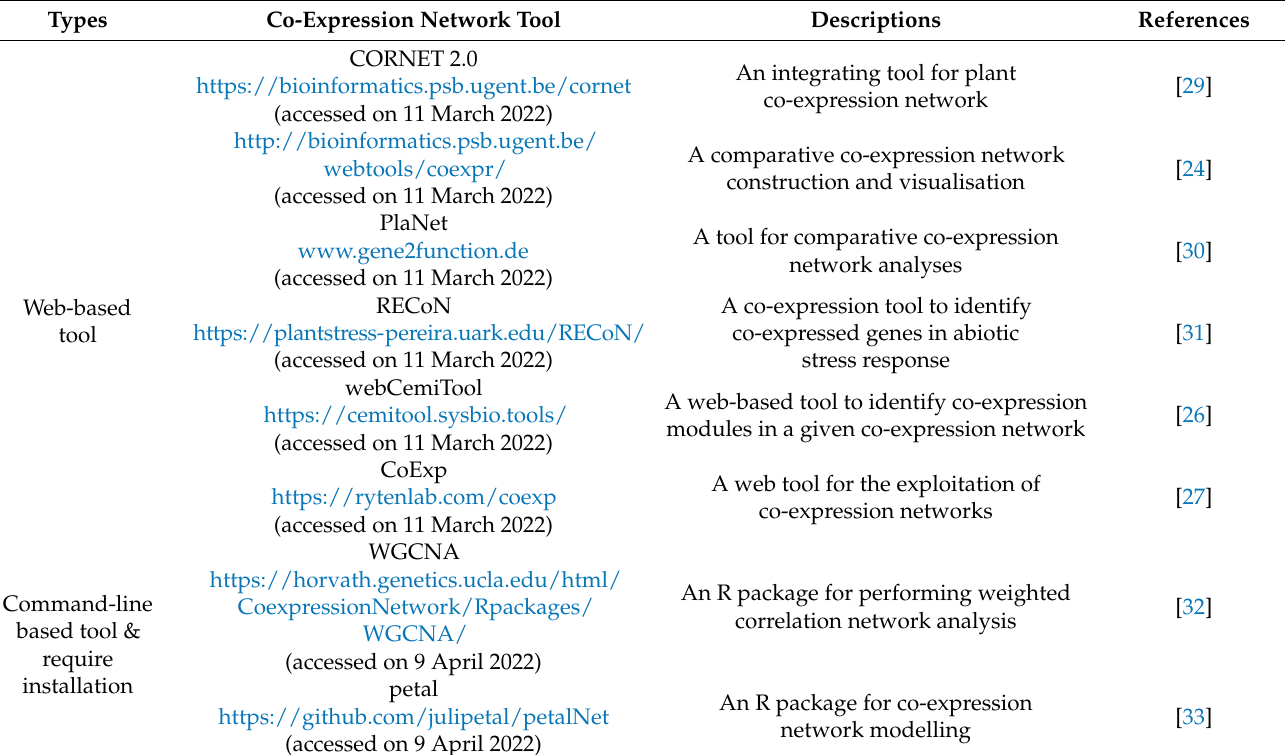
Table 1. List of co-expression tools for a gene co-expression network analysis in the